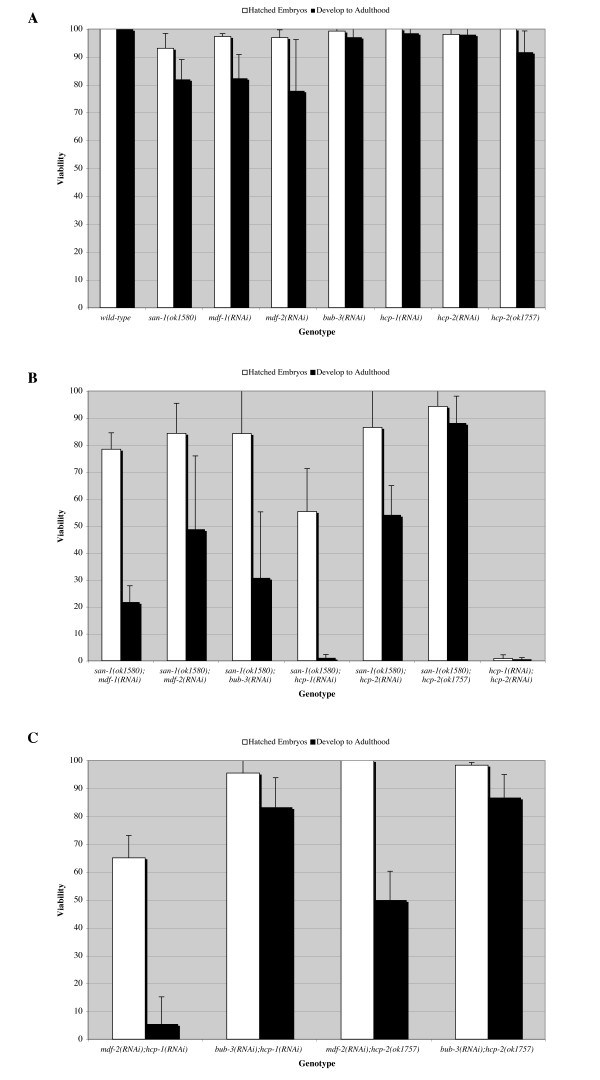
Synthetic lethality of spindle checkpoint genes. For graphs A, B, and C, the embryos, of the designated genotypes, were assayed for the ability to hatch (white filled bars) and the ability to develop to adulthood after three days on food (black filled bars). The san-1(ok1580);hcp-2(ok1757) animals were given four days to develop to adulthood. The data obtained is from four independent experiments with > 200 total animals assayed. Error bar is standard deviation.